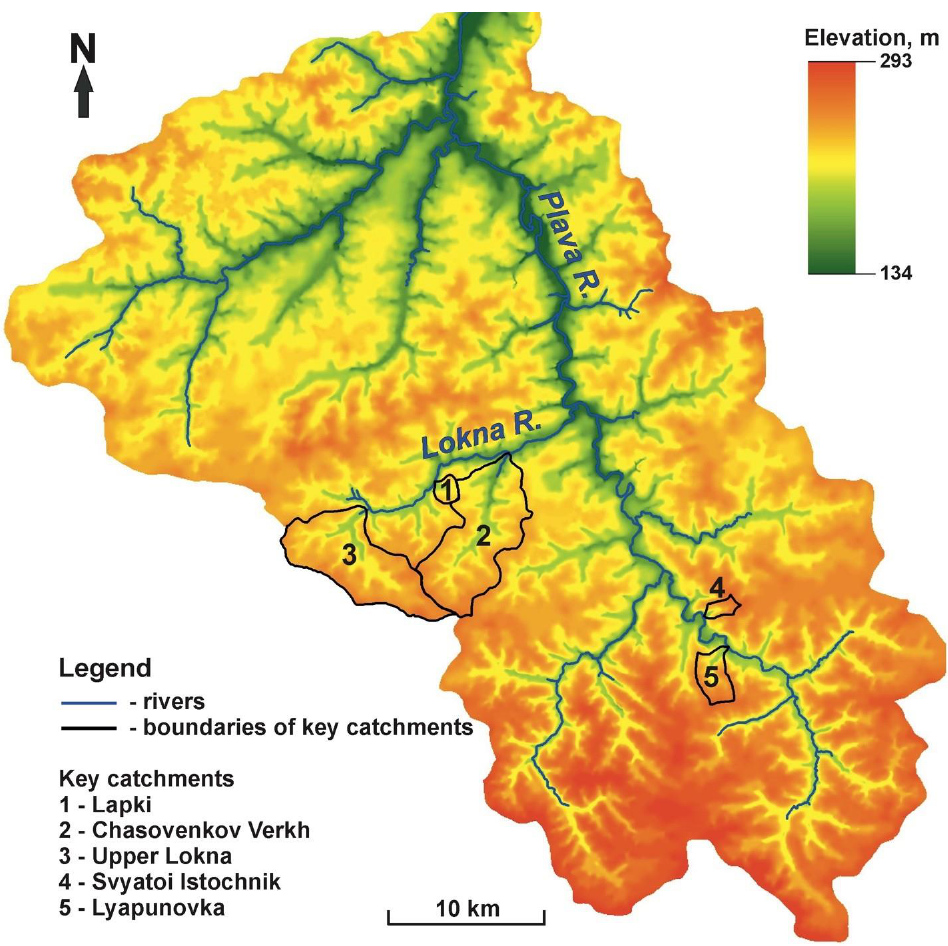
Figure 3. Locations of key catchments in Plava River basin. Table 1. Morphometric characteristics of studied key catchments in Plava River basin.